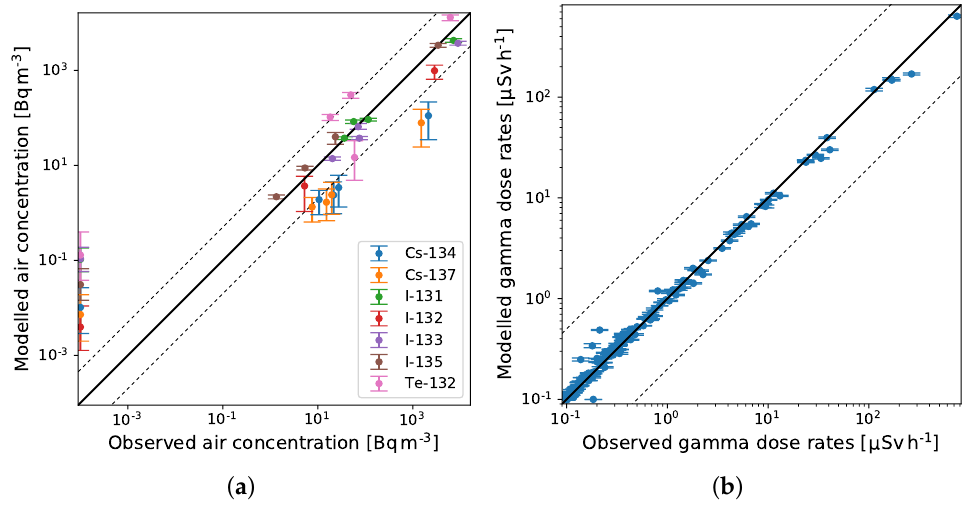
Figure 8. Model predictions with uncertainties (median and 10th and 90th percentile) on the y -axis, and observations on the x -axis. The solid black lines indicate a perfect correlation, while the dashed black lines indicate a factor of 5 between model and observation. ( a ) shows the filter measurements, whereas ( b ) shows the gamma dose